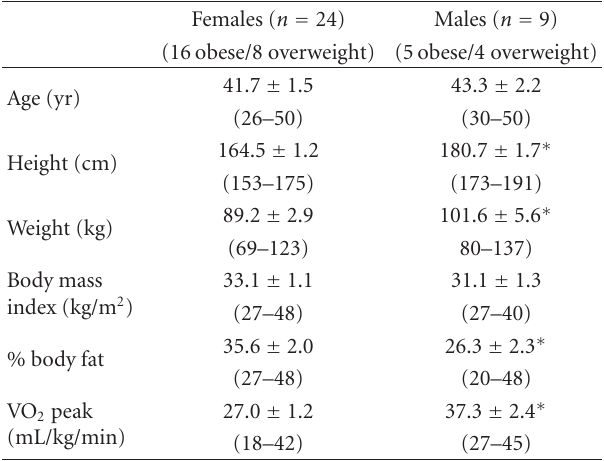
Table 1: Descriptive characteristics of the subject separated by